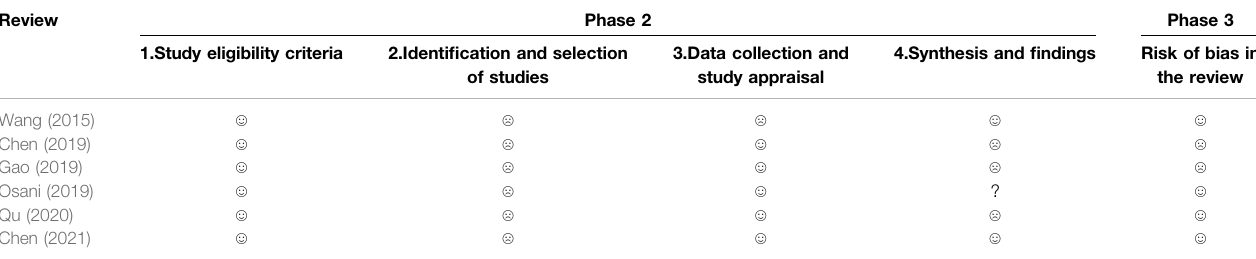
TABLE 4 | Results of the ROBIS tool.